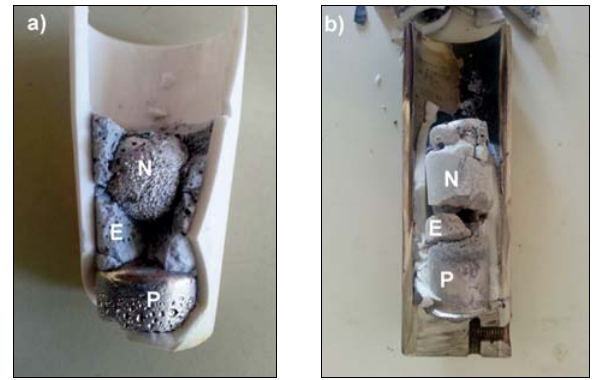
Figure 6. Vertical separation of phases after cooling to RT with the designations: N-negative electrode material, E-electrolyte phase, P- positive electrode material. (a) A typical parallel experiment where the melts were prepared in the alumina crucible (N = aluminium, E = NaF-AlF -BaCl -NaCl, P = bismuth). (b) Longitudinal section of 3 2 Al-Pb cell after electrochemical testing (N = aluminium, E = LiF- AlF -BaF , P = 3 2